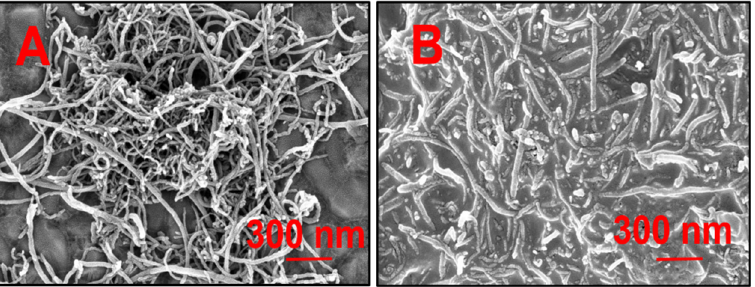
Figure 1. SEM images of CNPs-MWCNTs/GCE ( A ) and CuNPs-CSF-CNPs-MWCNTs/GCE ( B ), re- spectively. Electrodeposition potential: − 0.4 V. Electrodeposition time: 10 s. respectively. Electrodeposition potential: − 0.4 V. Electrodeposition time: 10 s.